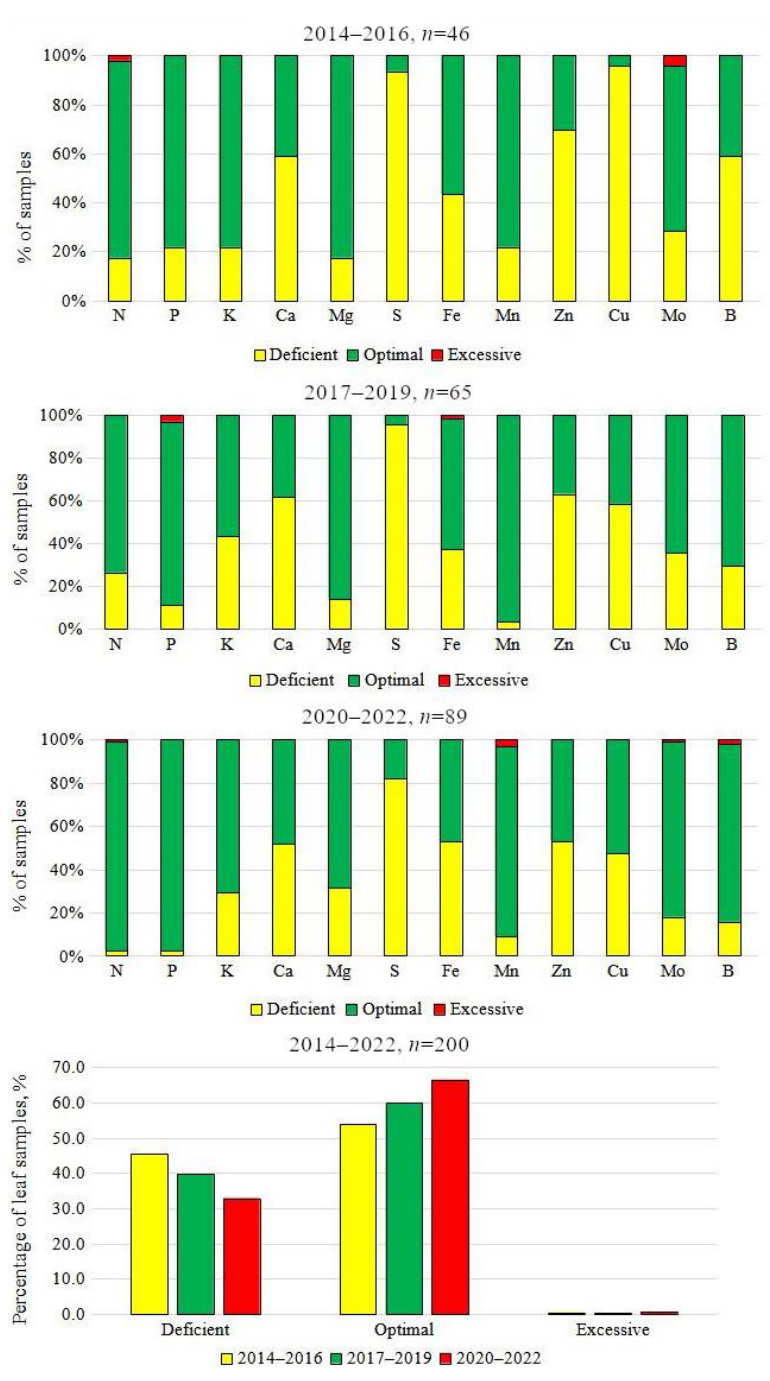
Figure 1. Distribution of strawberry leaf samples from commercial plantings in different nutrient supply levels in Latvia, 2014 – 2022.